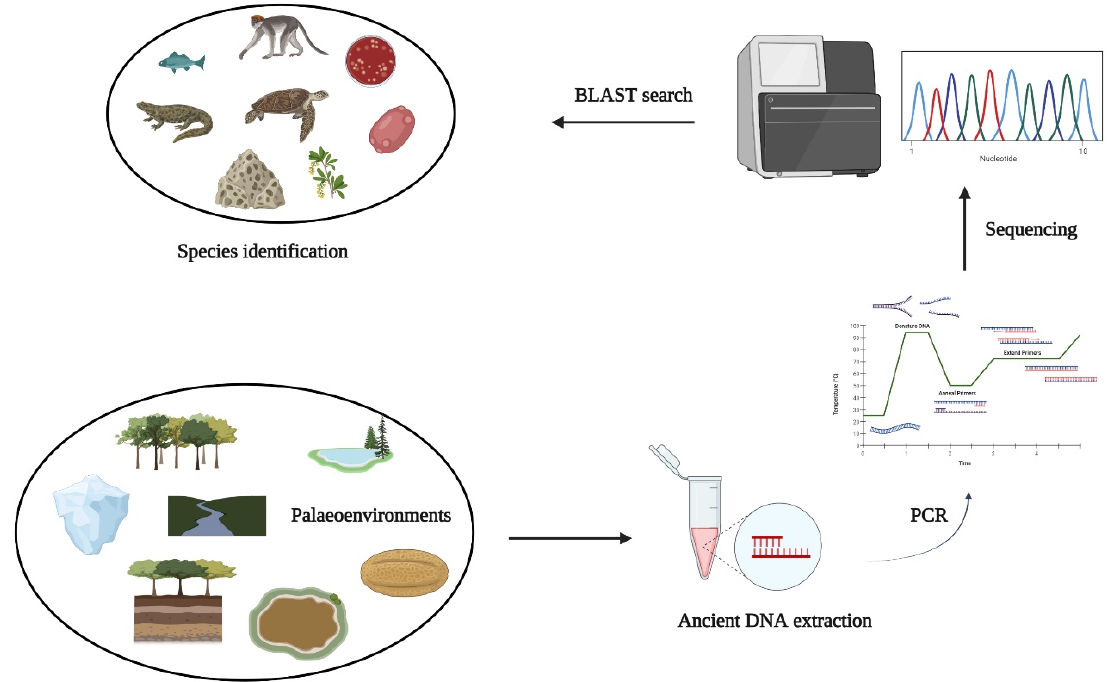
Figure 4. Processes involved in palaeoenvironmental reconstruction and species identification through eDNA.